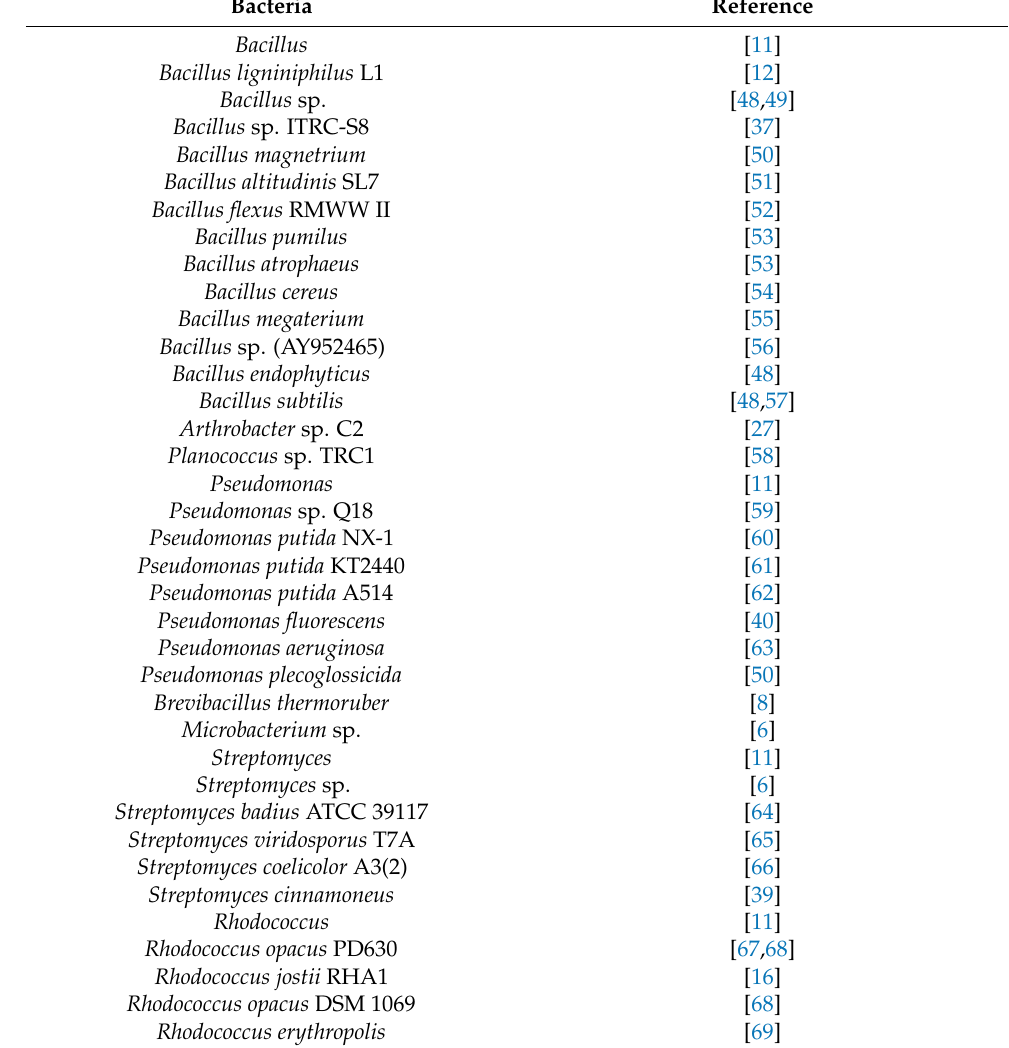
Table 1. Bacteria capable of lignin degradation and/or modification.